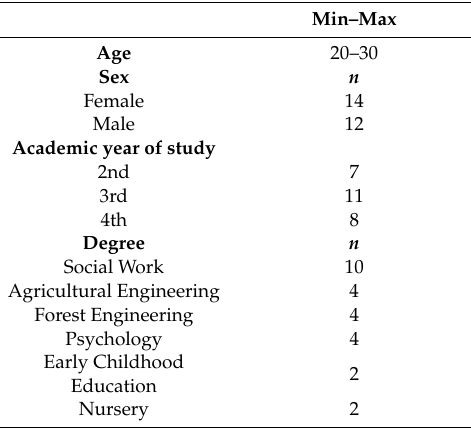
Table 1. Socio-demographic characteristics of the participants ( n =